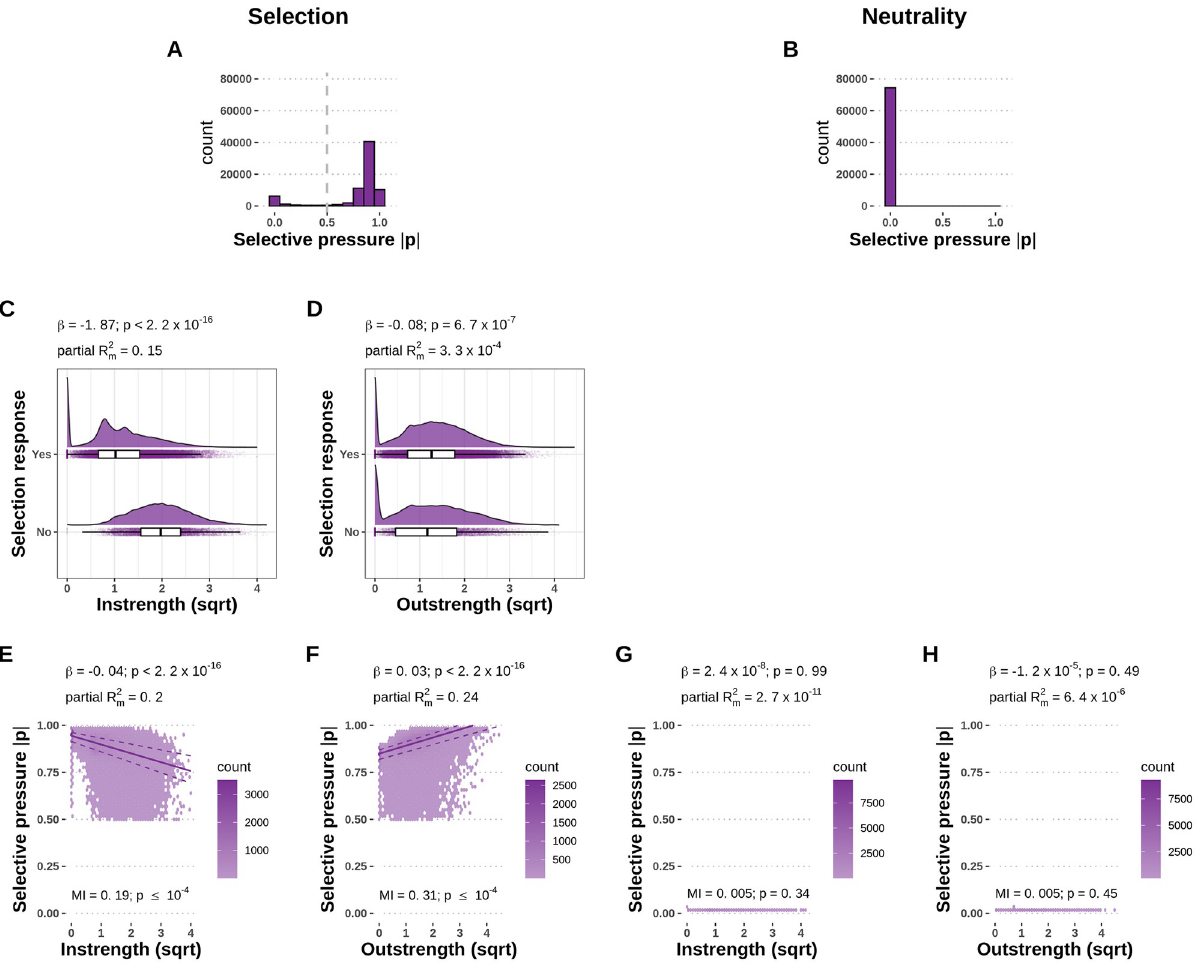
Fig 5. Differential selective pressure is acting on genes based on their centrality. A, B —Distributions of the measured selective pressure in selected (A) and neutral (B) populations. Genes with a selective pressure above 0.5 were categorized as responsive to selection. C, D —High instrength genes are less likely to respond to selection. Absolute instrength (C) has a strong significant negative effect on the probability of selection response. Absolute outstrength (D) has a weak significant negative effect on the probability of selection response. E, F —In the subset of genes that responded to selection, high instrength (E) decreases the selective pressure, while high outstrength (F) increases the selective pressure acting on individual genes. The lines indicate the 25% (lower dashed line), 50% (solid line), and 75% (upper dashed line) fitted quantiles. G, H —Absolute instrength (G) and outstrength (H) have no significant effect on the selective pressure in the non-selected populations. The dataset consists of 74,443 genes from 2,000 populations with unique 40-gene random network topology samples, which were independently evolved 10 times under selection and 10 times under neutrality. The selective pressure on each gene is calculated as the average normalized reduction of the intrinsic noise parameter during the evolutionary simulation and summarized as the mean over all replicates in each scenario. Coefficients, p-values and partial marginal R 2 measures are estimated using logistic regression and linear mixed-effects models with selection responsiveness or selective pressure as the response variable, instrength and outstrength as fixed effect explanatory variables, and the network topology sample as the random effect explanatory variable. Mutual information (MI) p-values were using 10,000